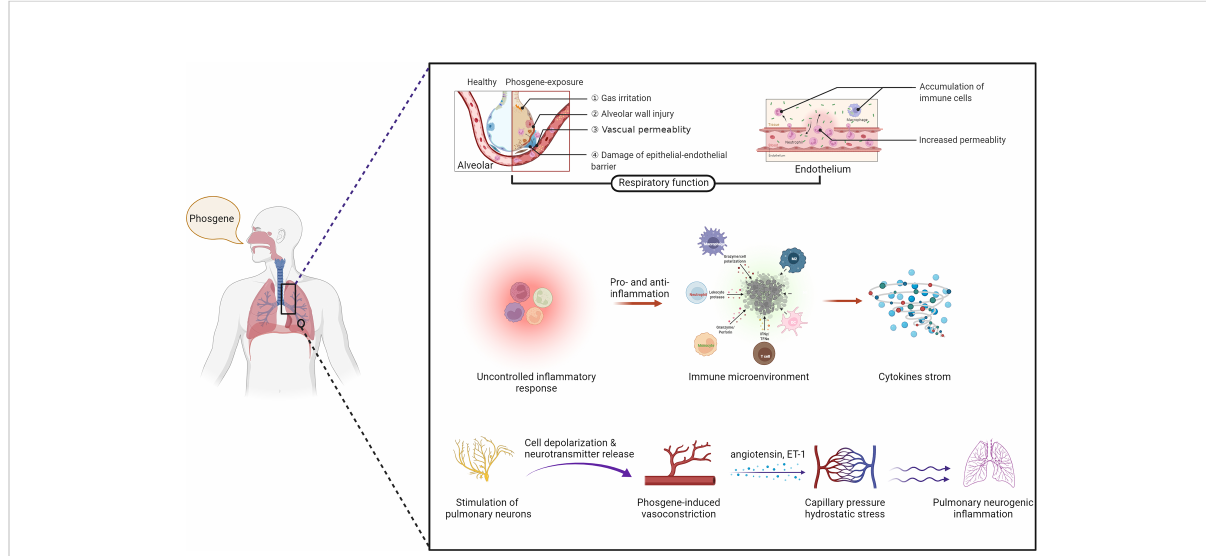
FIGURE 2 The mechanisms of phosgene-induced acute lung injury. Damage to the epithelial – endothelial barrier (upper layer), alteration of the immune microenvironment (middle layer) and stimulation of pulmonary neurons (bottom layer) (created with